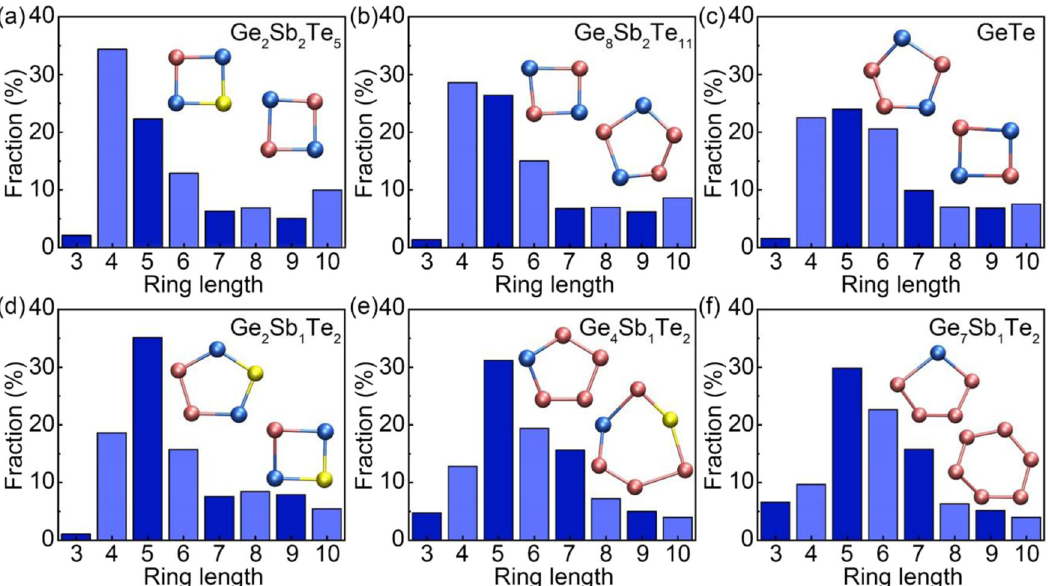
Fig. 3 Primitive rings statistics. The distribution of primitive rings for six amorphous alloys, including stoichiometric GST a Ge 2 Sb 2 Te 5 and b Ge